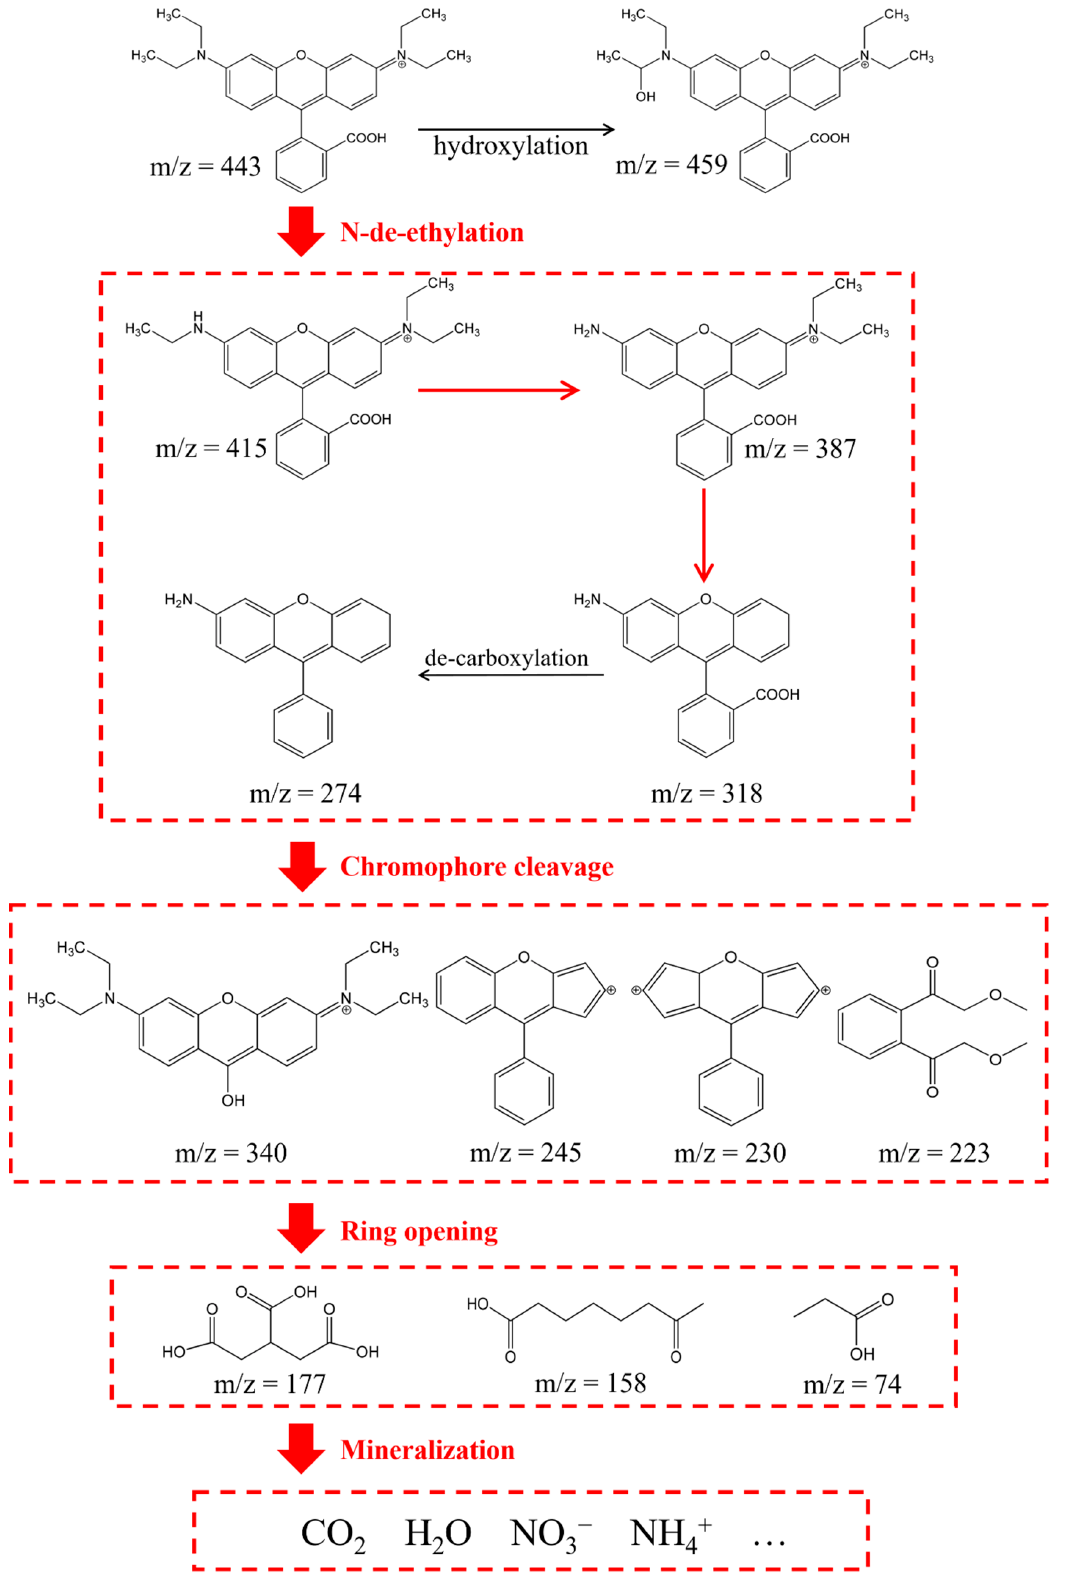
Figure 15. Illustration of the proposed Rh B degradation pathways.